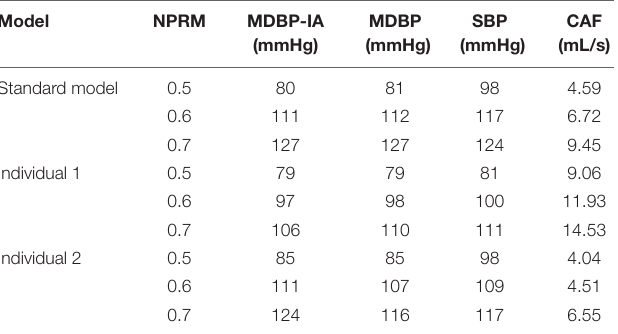
TABLE 5 | The simulated acute indicators of the three models under different pressurization